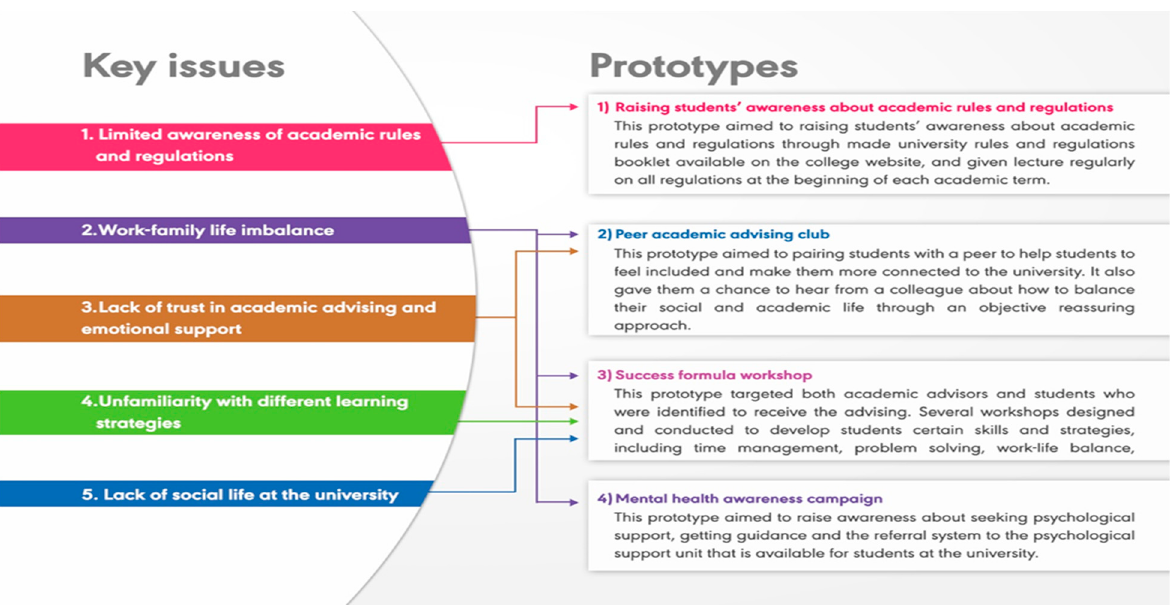
Table 2. Academic advising framework.